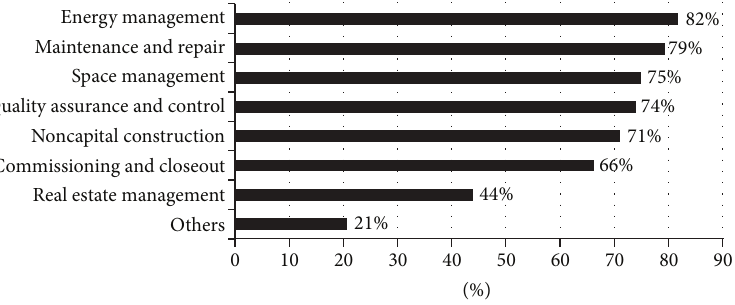
Figure 1: Proportion of each function [2].